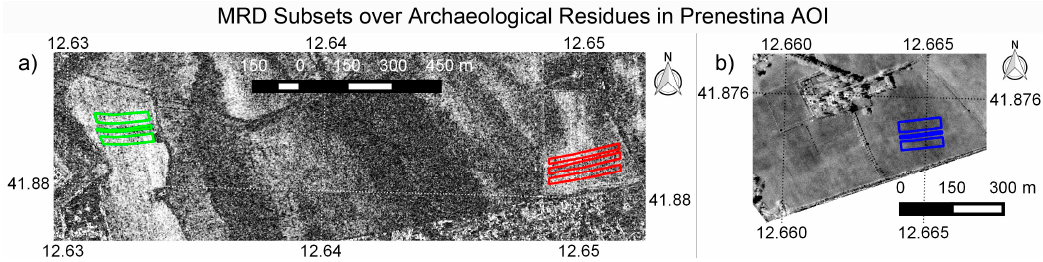
Figure 37. Subset areas shown as coloured polygons over and outside of residues used for MRD contrast analysis: ( a ) Green and red polygons over and outside of residues of Road 384. Polygons are overlain on CSK Spotlight coherence image from InSAR pair acquired on 9 and 25 July 2010; ( b ) Blue polygons over and outside of residue of Road 497. Polygons are overlain on σ 0 image acquired on 25 July 2010. COSMO SkyMed data provided by the Italian Space Agency.